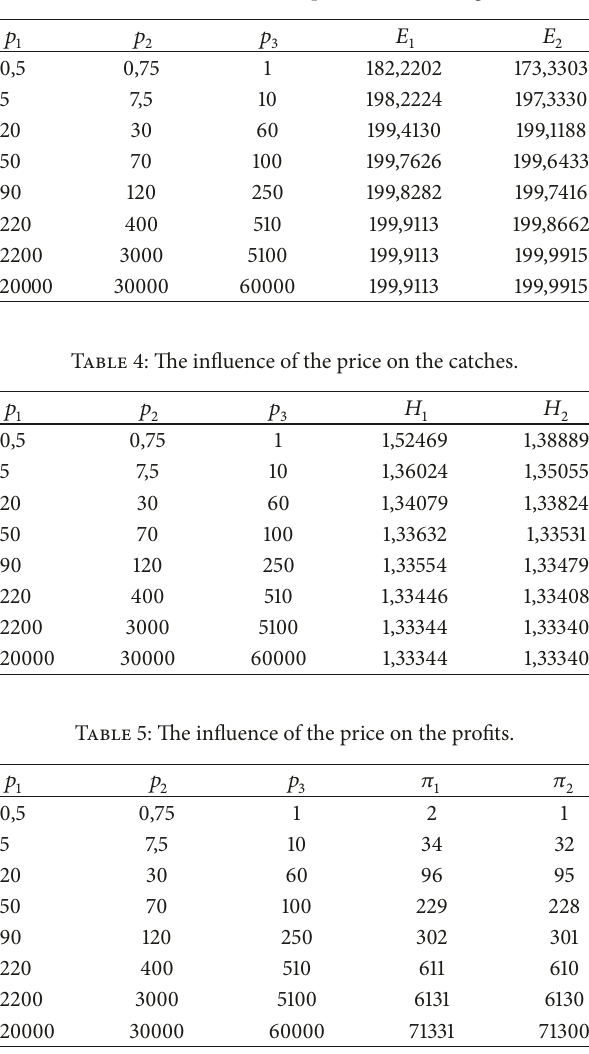
Table 2: Economic parameters of the model. Table 3: The influence of the price on the fishing effort.